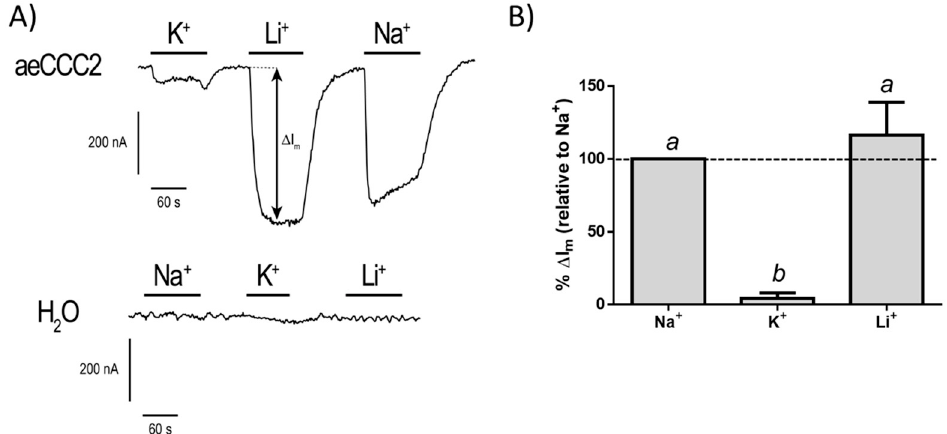
Figure 5. ( A ) Representative tracings of membrane current (I m ) in aeCCC2 or H 2 O-injected oocytes that were clamped at − 85 mV and − 100 mV, respectively. The bidirectional arrows signify the change in membrane current ( ∆ I m ); ( B ) Summary of relative effects of Na + , K + , and Li + on the ∆ I m in aeCCC2 oocytes. For each oocyte and cation, the ∆ I m values were normalized to the ∆ I m elicited by Na + and corrected for the average ∆ I m in H 2 O-injected oocytes ( N = 5) associated with that cation. Values are means ± SEM, based on four aeCCC2 oocytes. Lowercase letters indicate statistical categorization of the means based on a one ‐ way repeated ‐ measures ANOVA and Tukey’s post ‐ test ( p < 0.05 ).